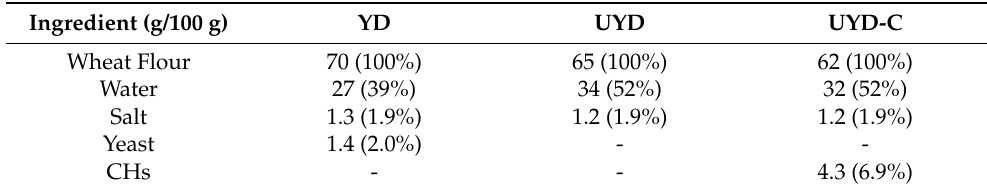
Table 4. Formulations used for the wheat doughs: yeasted wheat dough (YD), unyeasted control dough (UYD) and CH-rich unyeasted dough